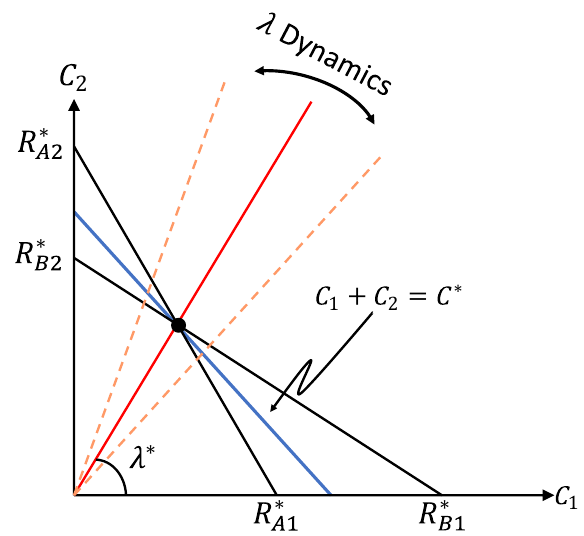
Figure 6. A schematic for nullcline analysis showing the prey subpopulations as two resources. Nullclines for A and B are shown in black; the intercepts are the amount of a single resource that a consumer needs to survive, R ∗ Ai = a 0 / a i and R ∗ Bi = b 0 / b i . The total population of C is represented by a line with slope − 1 . Prey composition (cid:31) is represented by the angle of a line going through the origin. The equilibrium values of C ∗ and (cid:31) ∗ at three-species coexistence is determined by the intersection of the nullclines. However, for our models of heterogeneous interactions, the dynamics of (cid:31) and its stability at (cid:31) ∗ are undetermined by this